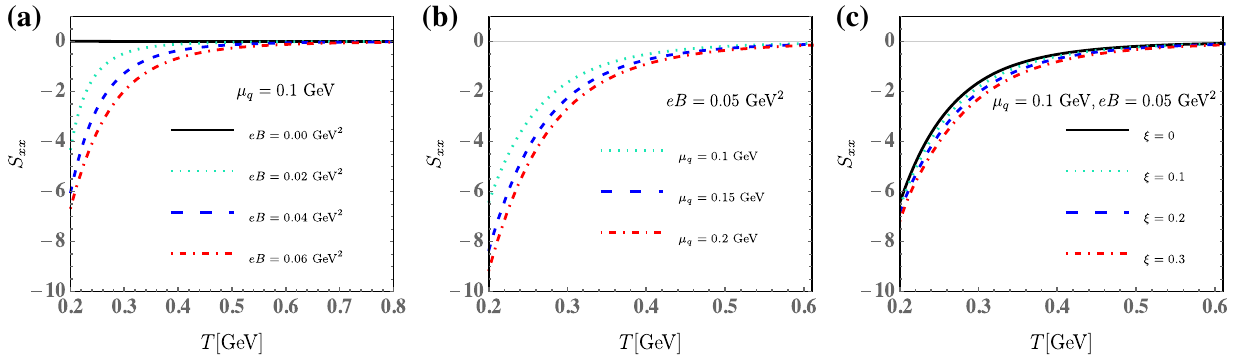
Fig. 4 a The temperature dependence of the Seebeck coefficient ( S xx ) for μ q = 0 . 1 GeV at different magnetic fields, namely eB = 0 GeV 2 (blacksolidline),0.02GeV 2 (cyandottedline),0.04GeV 2 (bluedashed line), 0.06 GeV 2 (red dotted-dashed line). b The temperature depen- dence of S xx for eB = 0 . 05 GeV 2 at μ q = 0.1 GeV (cyan dotted line),